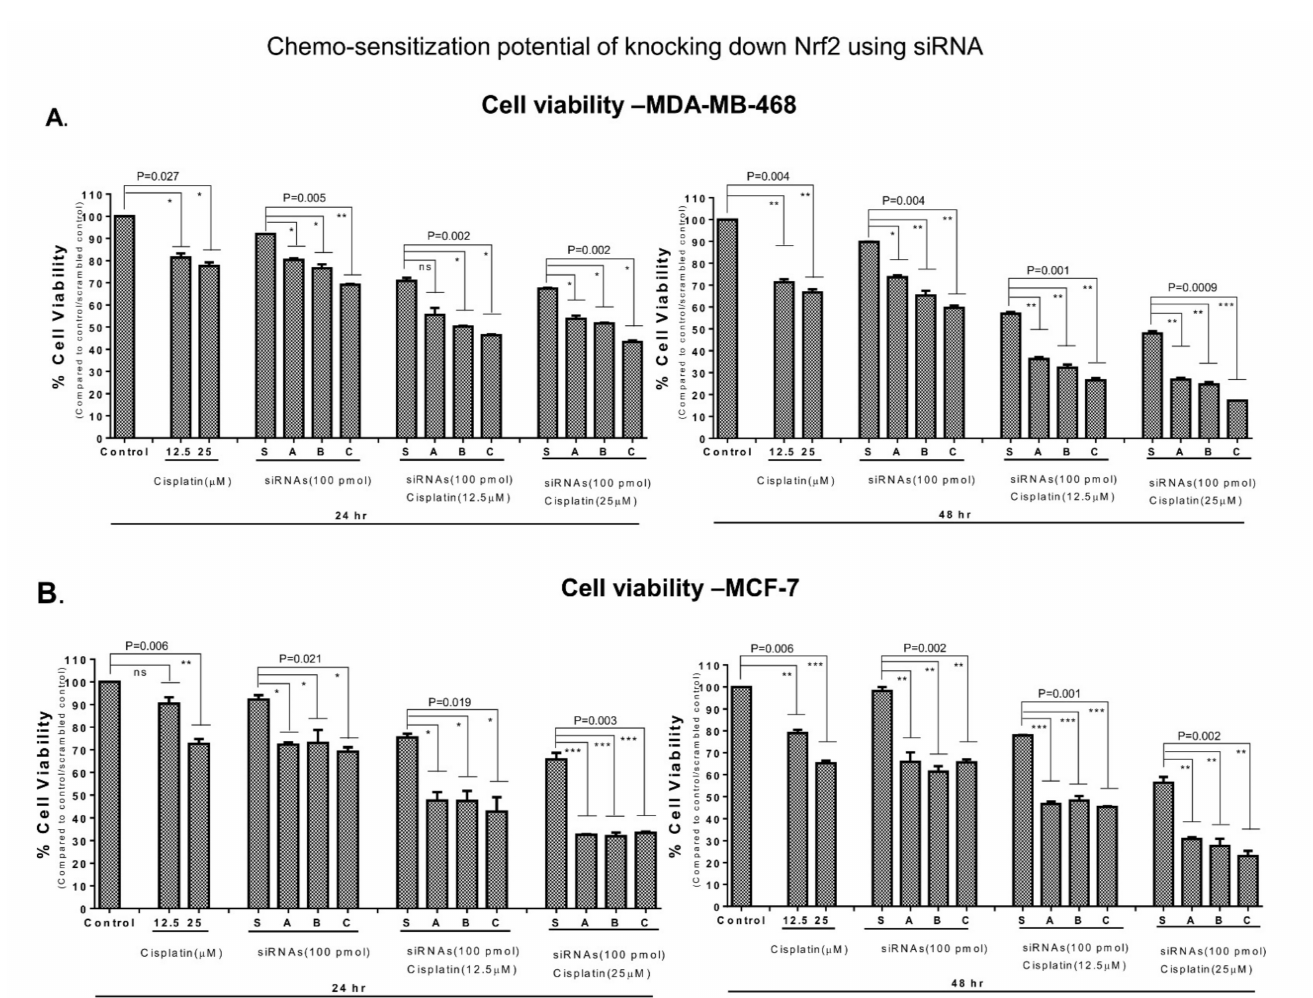
Figure 3. Nrf2 downregulation sensitized BC cells to chemotherapy drug cisplatin: ( A ) Nrf2 downregulation resulted in inhibition of MDA-MB-468 cells viability. Significant decrease in cell viability was observed for combined Nrf2 knockdown (siNrf2-A, siNrf2-B, and siNrf2-C) and cisplatin treatment (24 h treatment; p value = 0.002; 48 h of treatment; p value = 0.0009). ( B ) Similar effects were observed in MCF-7 cells (24 h treatment; p value = 0.003; 48 h of treatment; p value = 0.002). One-way ANOVA test was used for the data analysis (* p < 0.05, ** p < 0.01, *** p < 0.005). ns refers to